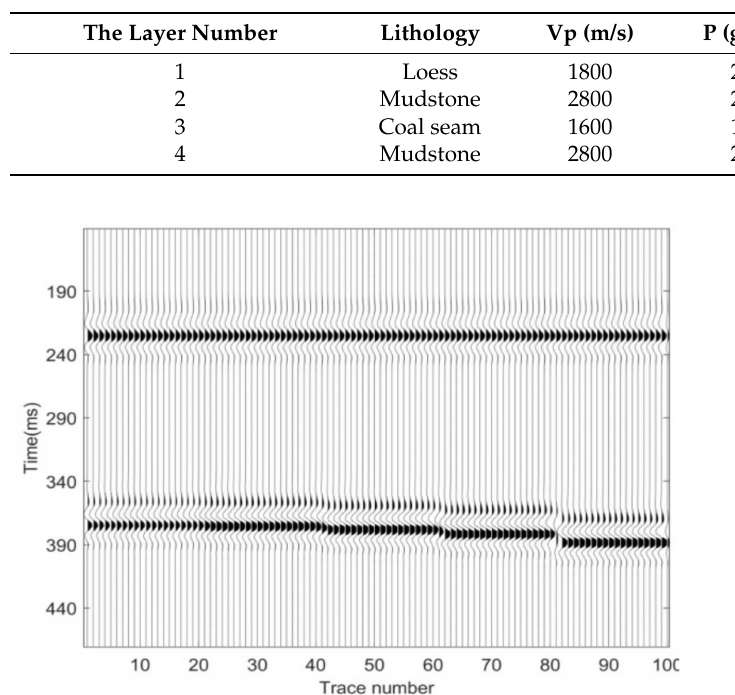
Figure 4. Synthetic seismograms of fault models with different